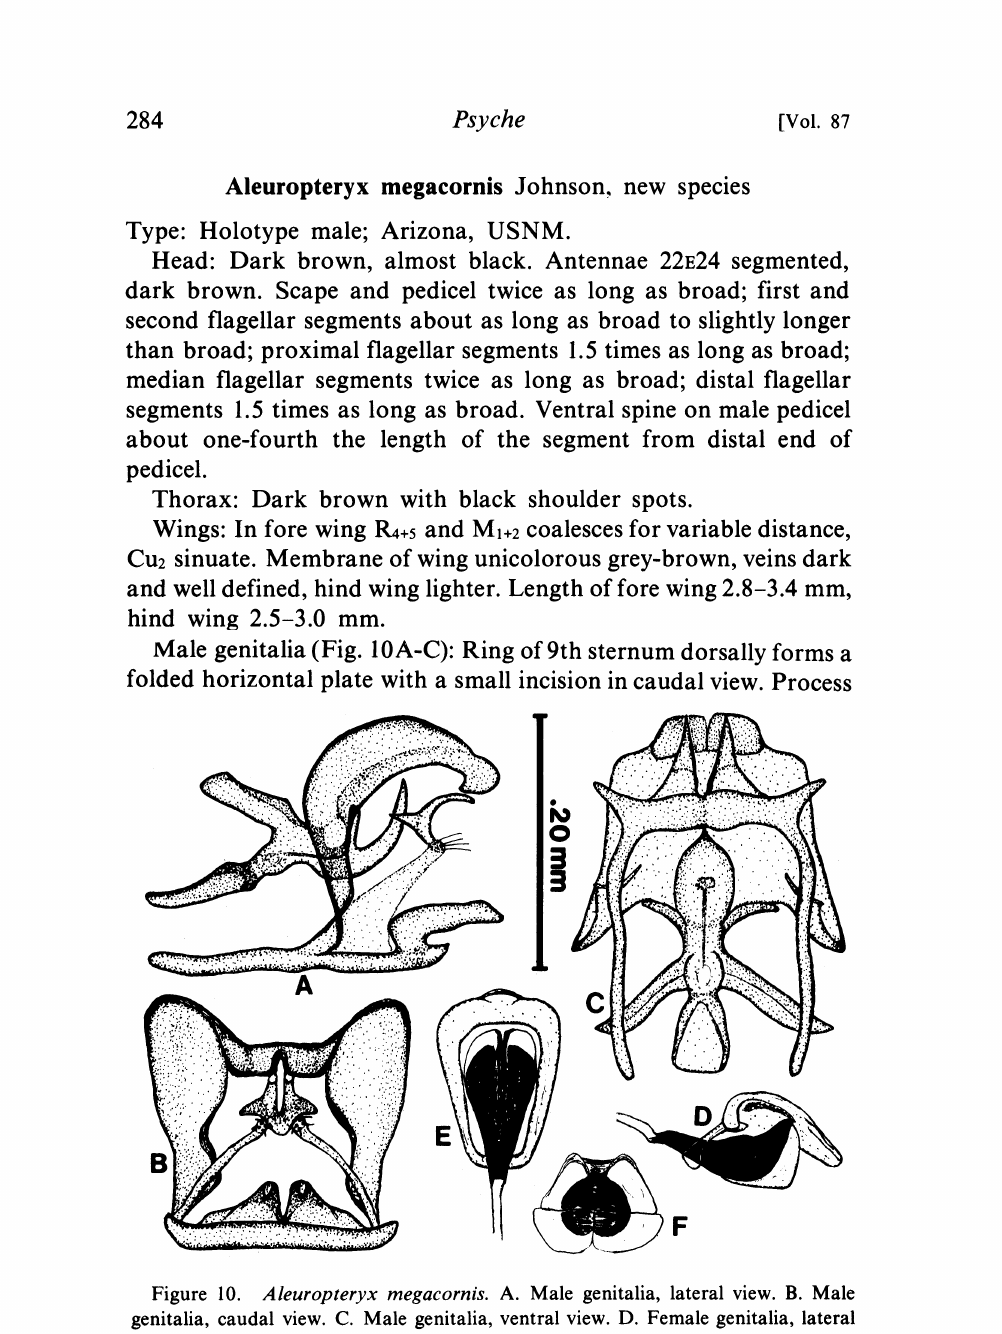
Figure 10. Aleuropteryx megacornis. A. Male genitalia, lateral view. B. Male genitalia, caudal view. C. Male genitalia, ventral view. D. Female genitalia, lateral view. E. Female genitalia, ventral view. F. Female genitalia, caudal